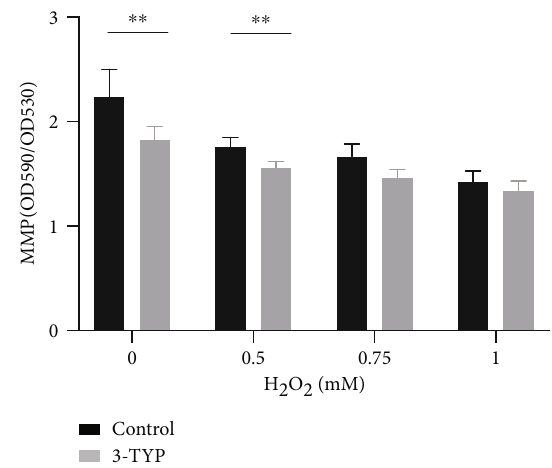
Figure 4: Comparison of MMP levels in the 0, 0.5, 0.75, and 1mM groups between matched nontreated and 3-TYP-treated groups. Data are expressed as means ± SD ( n = 5 organ of Corti per concentration). ∗ P < 0 : 05 , ∗∗ P < 0 : 01 , and ∗∗∗ P < 0 : 001